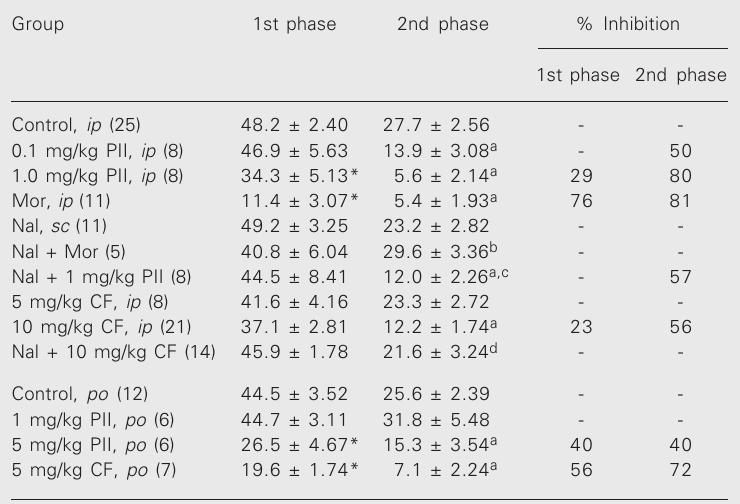
Table 2. Antinociceptive effect of the PII and carbohydrate fractions from Bryothamnion seaforthii on the formalin test in male Swiss